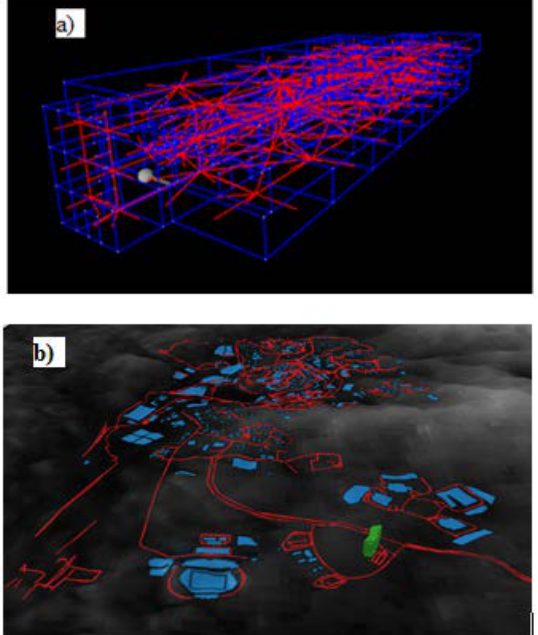
Figure 11. Indoor and Outdoor building modeling a) indoor building model b) outdoor building model (green colored building) integrated with navigation network and